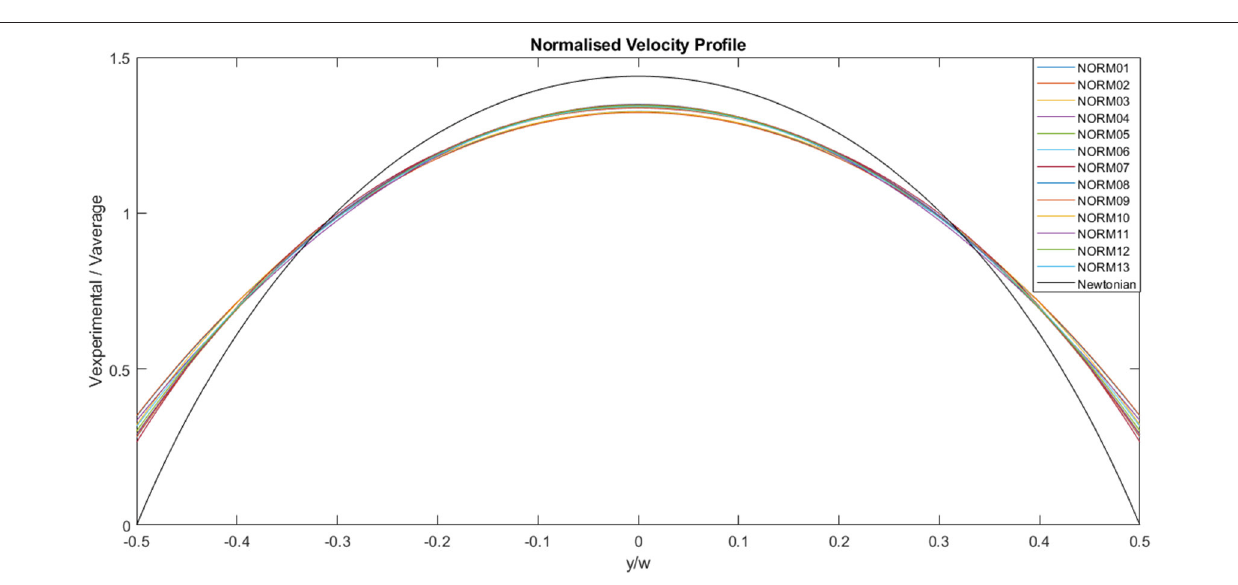
FIGURE 7 | Normalized, experimentally derived, flow velocities across channel width for a range of flow rates. The solid black line represents the analytical profile for a Newtonian